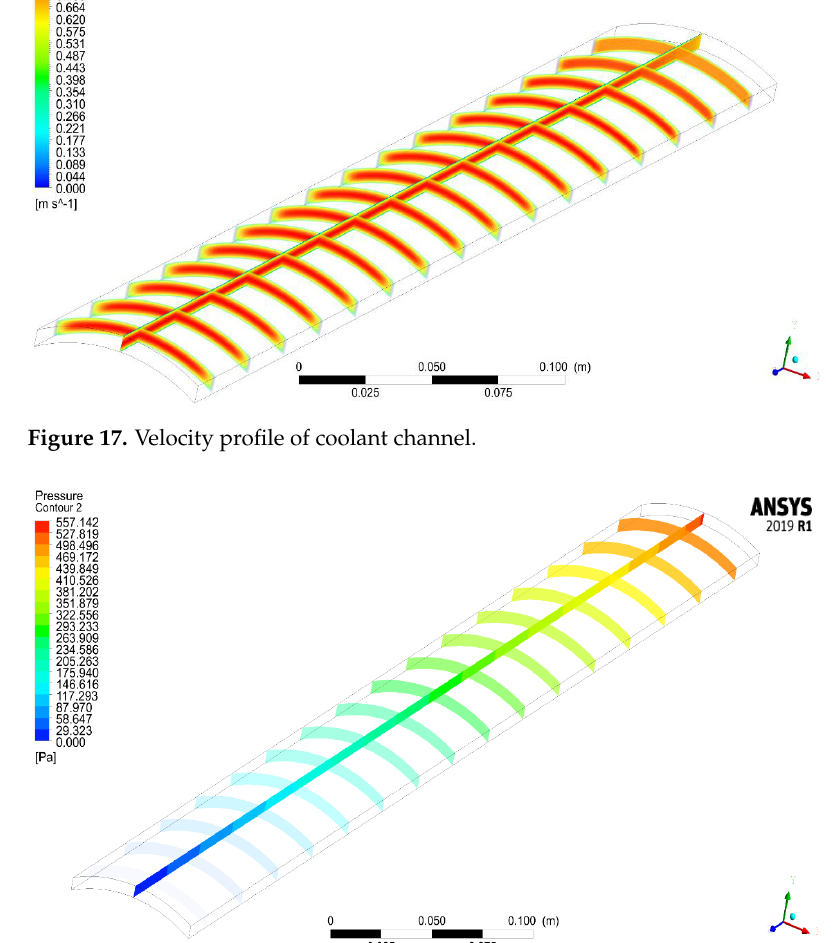
Figure 18. Pressure profile of coolant channel.